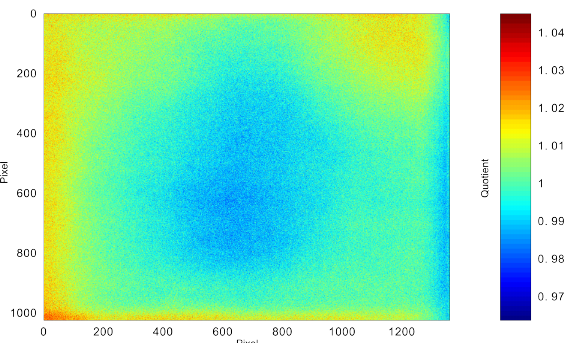
Figure 9: Flat field correction matrix (FFC) calculated from the integrating sphere divided by Flat field correction matrix (FFC_LED) calculated from the LED